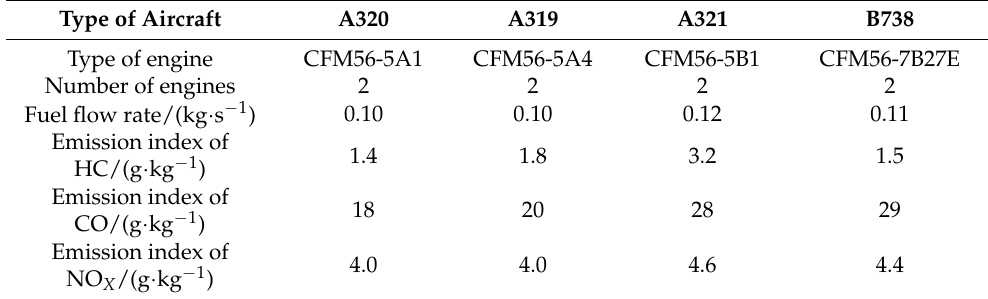
Table 4. Fuel flow rate and emission index of some aircraft types when engine operating status is